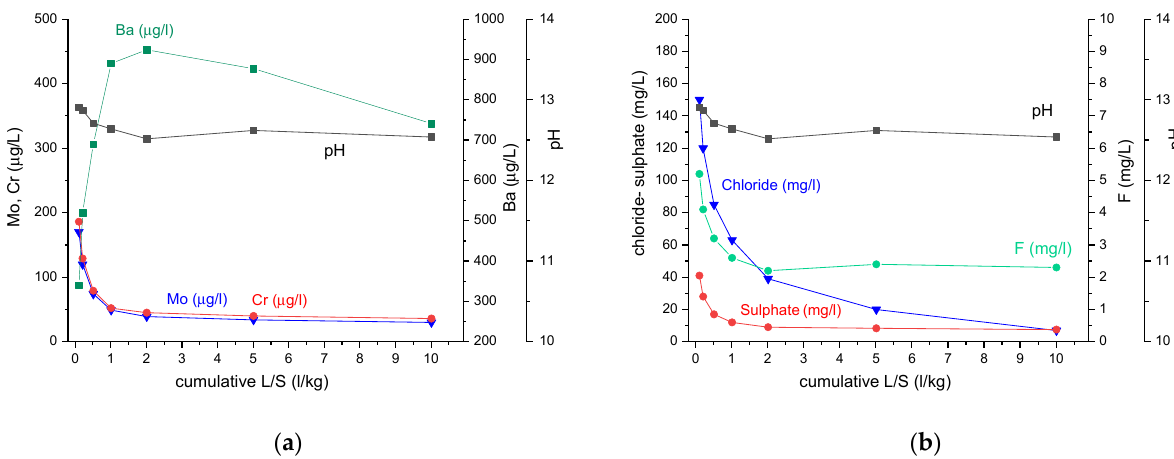
Figure 10. Leaching behavior of concrete aggregates as a function of cumulative L/S. ( a ) Leaching of Ba, Cr and Mo ( b ) Leaching of chloride, sulphate and fluoride.